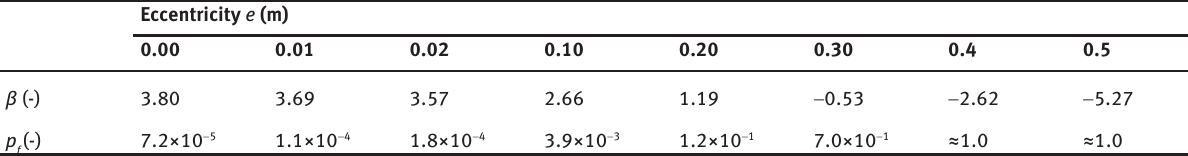
calculated (based on Table 3) for θ f